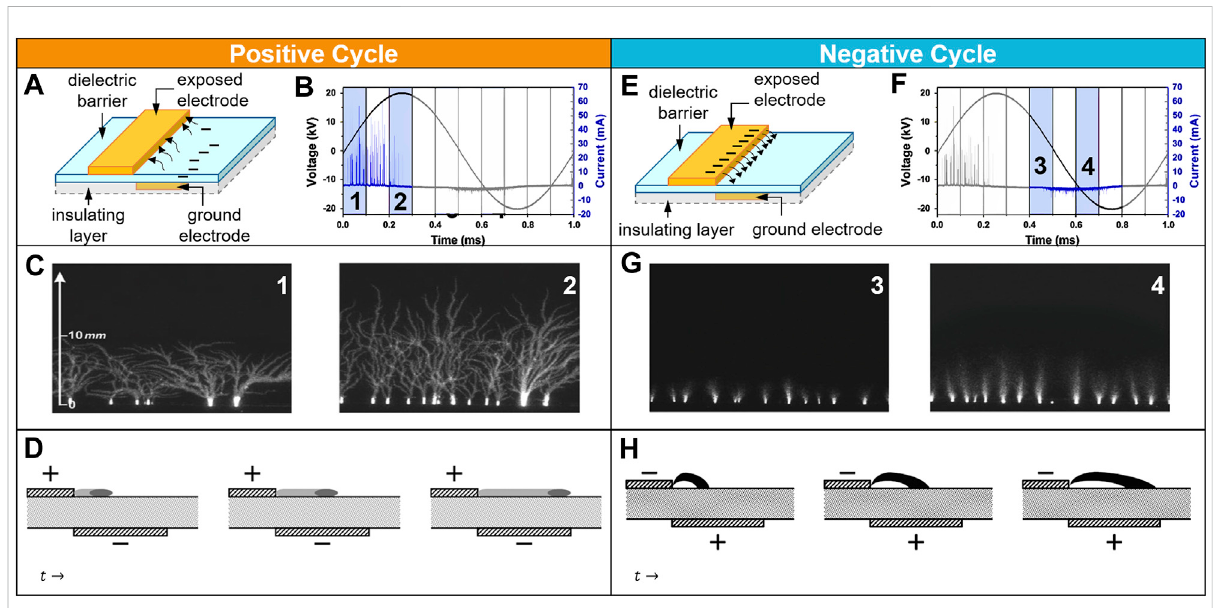
FIGURE 2 (A) Schematicofdischargeexchangeduringthenegative-goingcycle;concepttakenfrom[45]. (B) SDBD ’ scharacteristicvoltageandcurrentin thepositivehalf-cycle[39]. (C) Fast-imagingofthedevelopingplasma[38,39]. (D) Schematicshowingtheexpansionofthedischargeswithtime[35]. (E) Schematic of discharge exchange during the positive-going cycle; concept taken from [45]. (F) SDBD ’ s characteristic voltage and current in the negative half-cycle [39]. (G) Fast-imaging of the developing plasma [38, 39]. (H) Schematic showing the expansion of the streamers with time